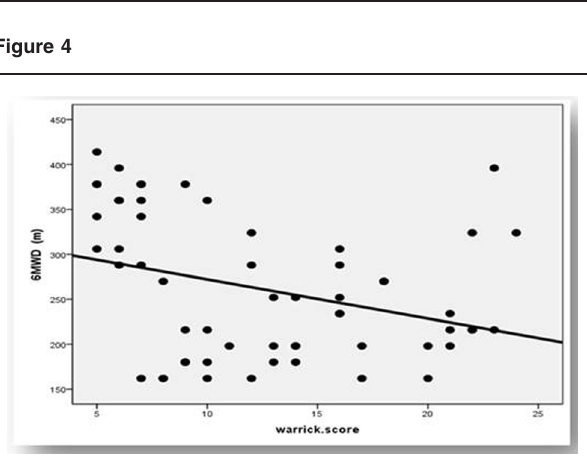
Illustrates the relation between Warrick score and PaO 2 .